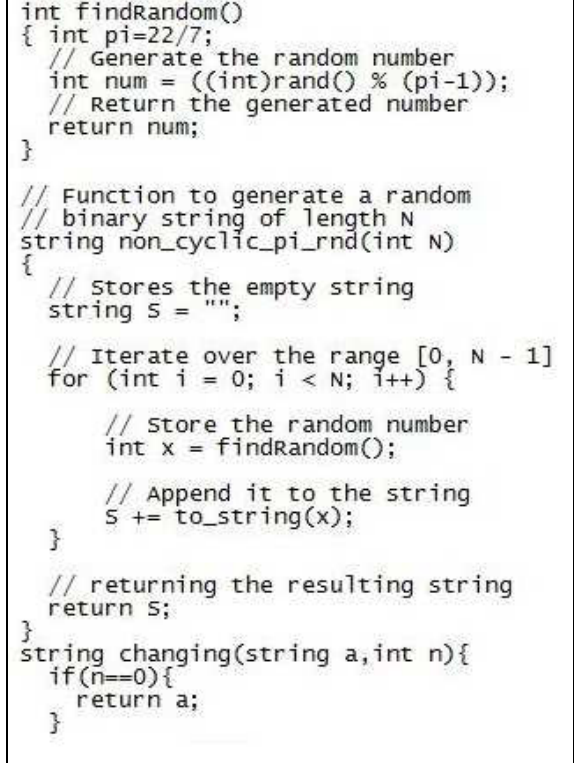
Figure A5. Function to generate random binary strings .